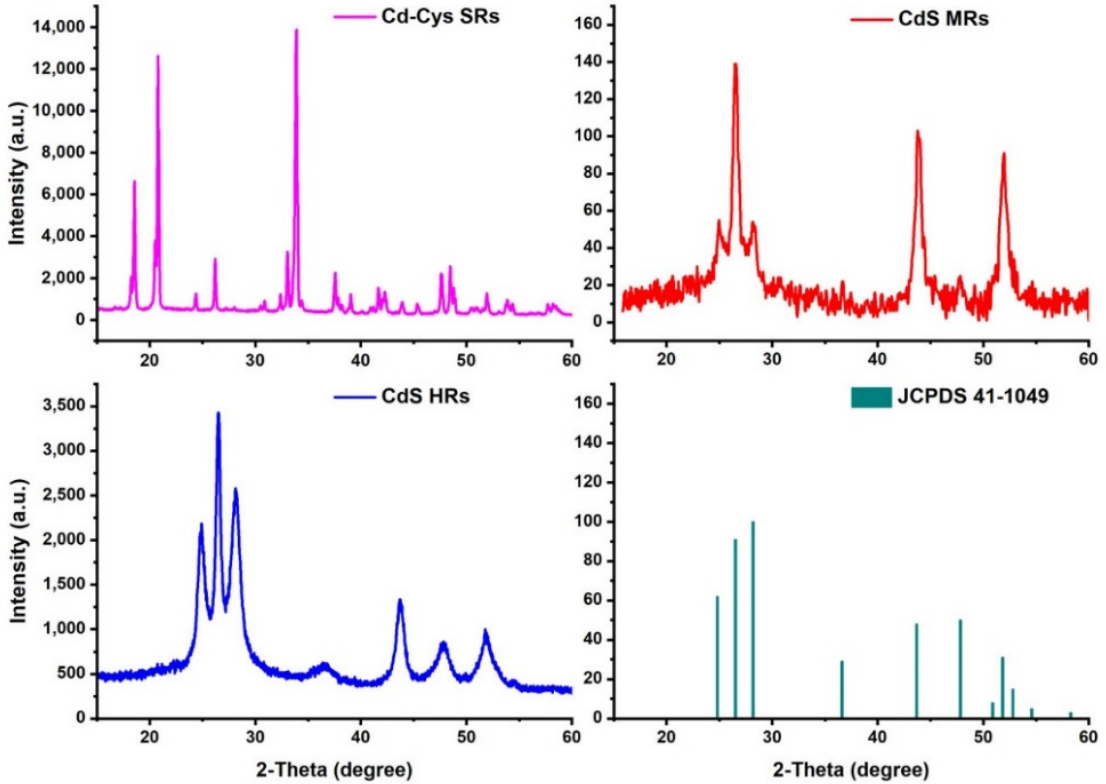
Figure 3. XRD patterns of samples.